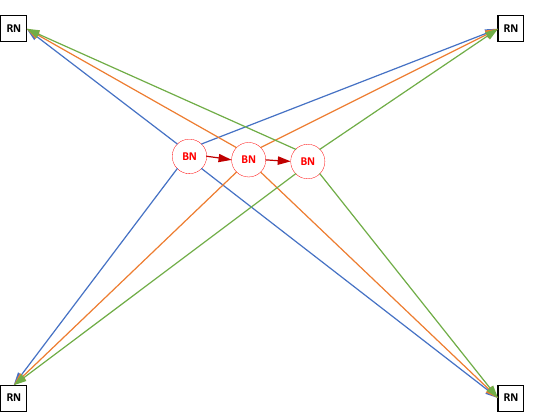
Figure 2. The proposed location technique using multi-spot TOA measurements.